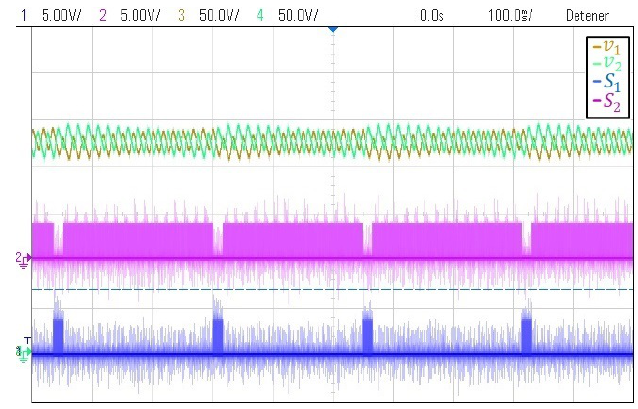
Figure 23. Waveforms of v 1 , v 2 , S 1 and S 2 for I s =